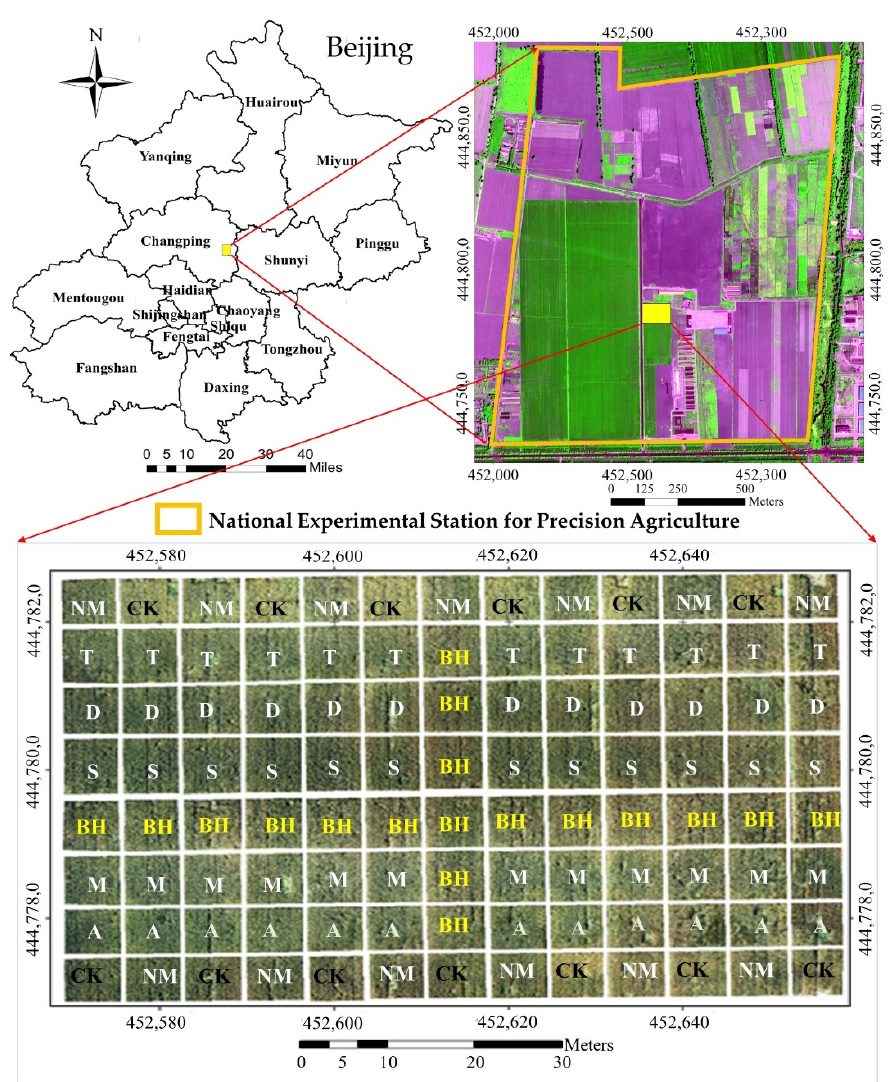
Figure 1. Study area and experimental design. NM treatment: A recommended conventional,